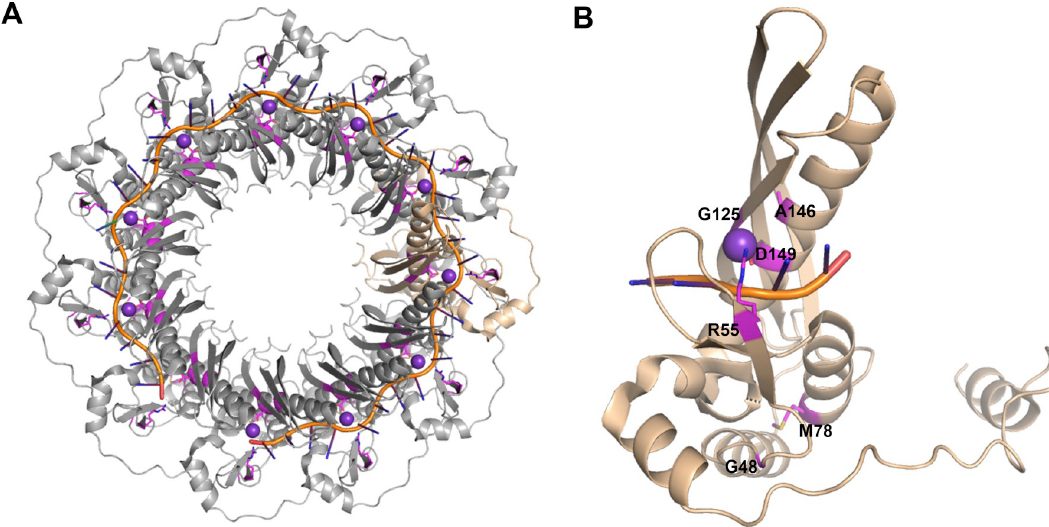
Fig 4. Location of mutated residues on the structure of RAD52. A . The structure of RAD52 with single-stranded DNA bound to the inner site (PDB ID: 5XRZ) was used to map the mutated residues, shown in magenta. The DNA is shown in orange with bases in dark blue and potassium ions are shown as purple spheres. RAD52 is shown in gray with a single monomer represented in tan. B . The tan single monomer is shown individually, and side chains of mutated residues shown as magenta sticks.